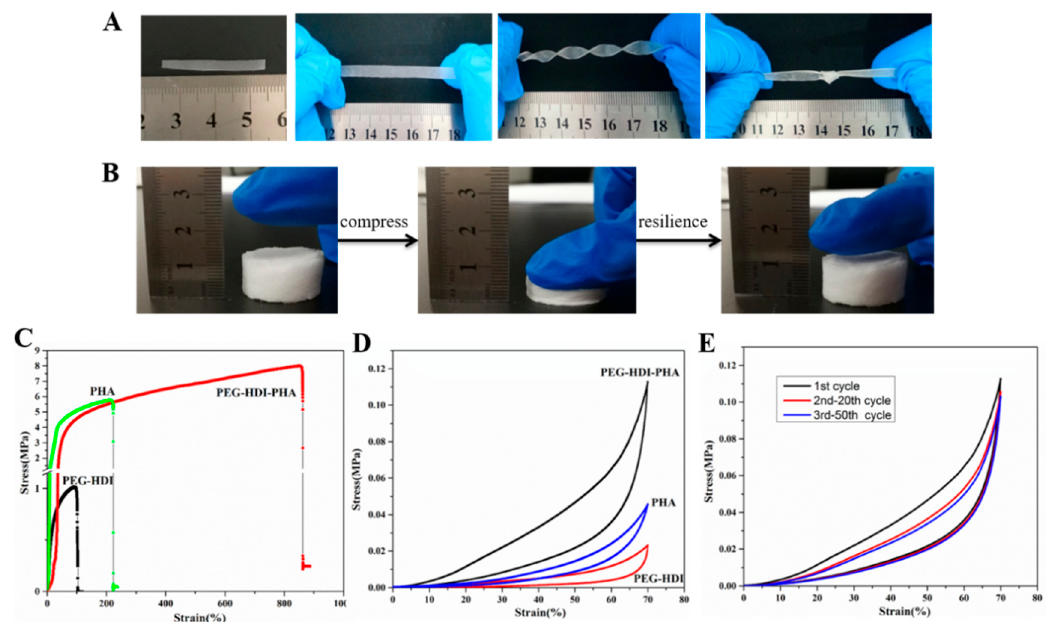
Figure 4. ( A ) Photographs of PHP films showing original length and length after being stretched at λ = 3, and their ability to withstand large stretching, twisting, and knotting; ( B ) Photographs of PHP porous sca ff old showing compressibility and resilience; ( C ) Tensile stress–strain curves of PHP films; ( D ) Compressive stress–strain curves of PHP porous sca ff old; ( E ) The relaxation cycles to the same polyethylene glycol (PEG)–hexamethylenediisocyanate (HDI)–polyhydroxyalkanoate (PHA) for 50 cycles under a compression of 70%.